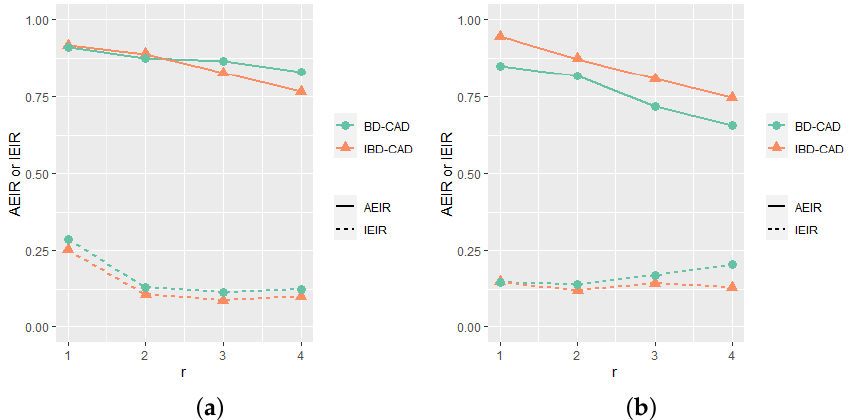
Figure 1. AEIR and IEIR versus the number of newly added factors r for β ∼ N ( 6,1 ) . ( a ) SSD ( 8,13 ) , n 2 = 12. ( b ) SSD ( 7,15 ) , n 2 =